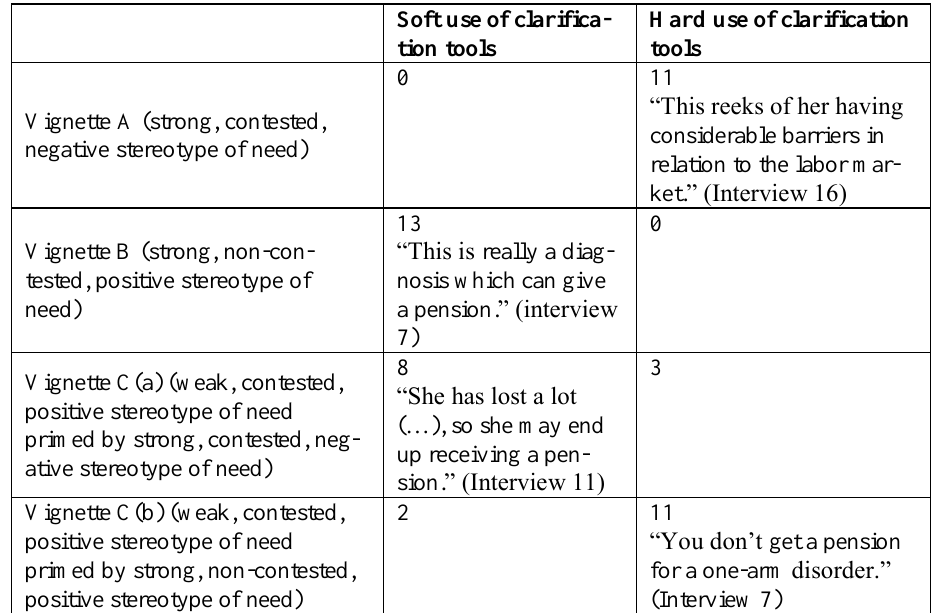
Stereotypes of need and purpose of clarification